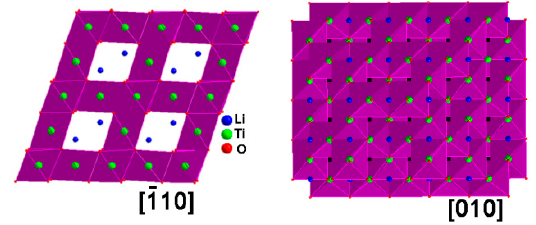
Figure 7. LTO crystal structure view from [ 1(cid:3364) 10] and [010].